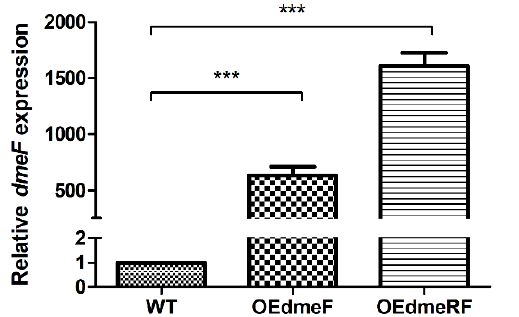
Figure 5. qRT-PCR analysis of dmeF expression in the WT, OE dmeF , and OE dmeRF strains. Results represent the means and SD from three biological replicates. The data were analyzed using one-way analysis of variance along with Bonferroni’s post-test. ***, p < 0.001.